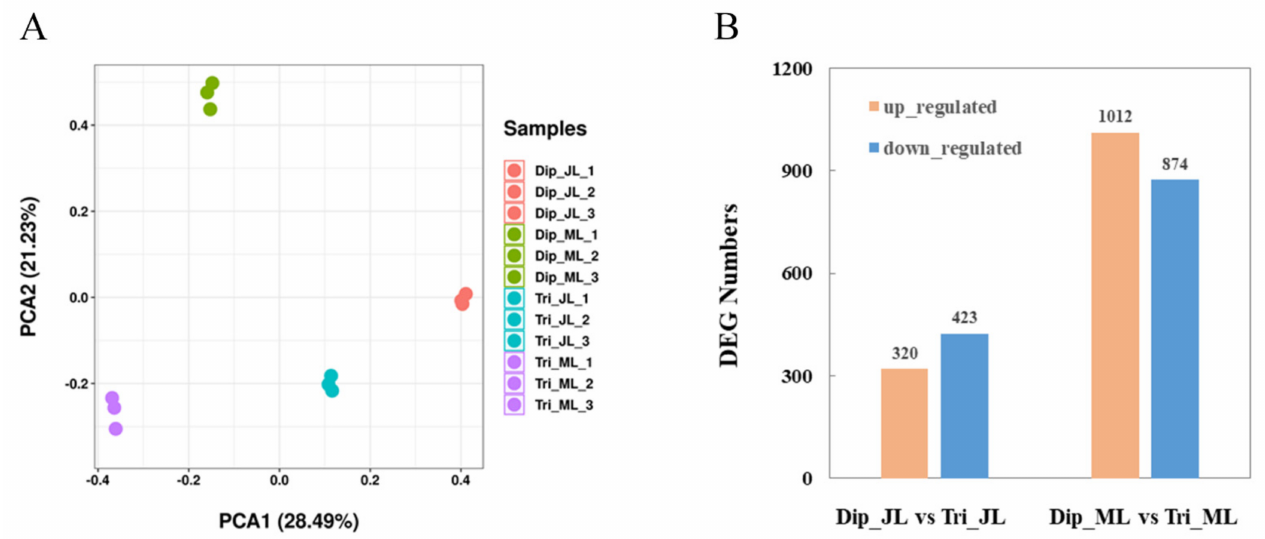
Figure 2. Analysis of transcriptome sequencing data. ( A ) Principal component analysis (PCA) analysis of transcriptome sequencing samples. ( B ) Numbers of differentially expressed upregulated and downregulated genes in juvenile and mature leaves between triploids and diploids. Dip_JL, juvenile diploid leaves; Dip_ML, mature diploid leaves; Tri_JL, juvenile triploid leaves; Tri_ML, mature triploid